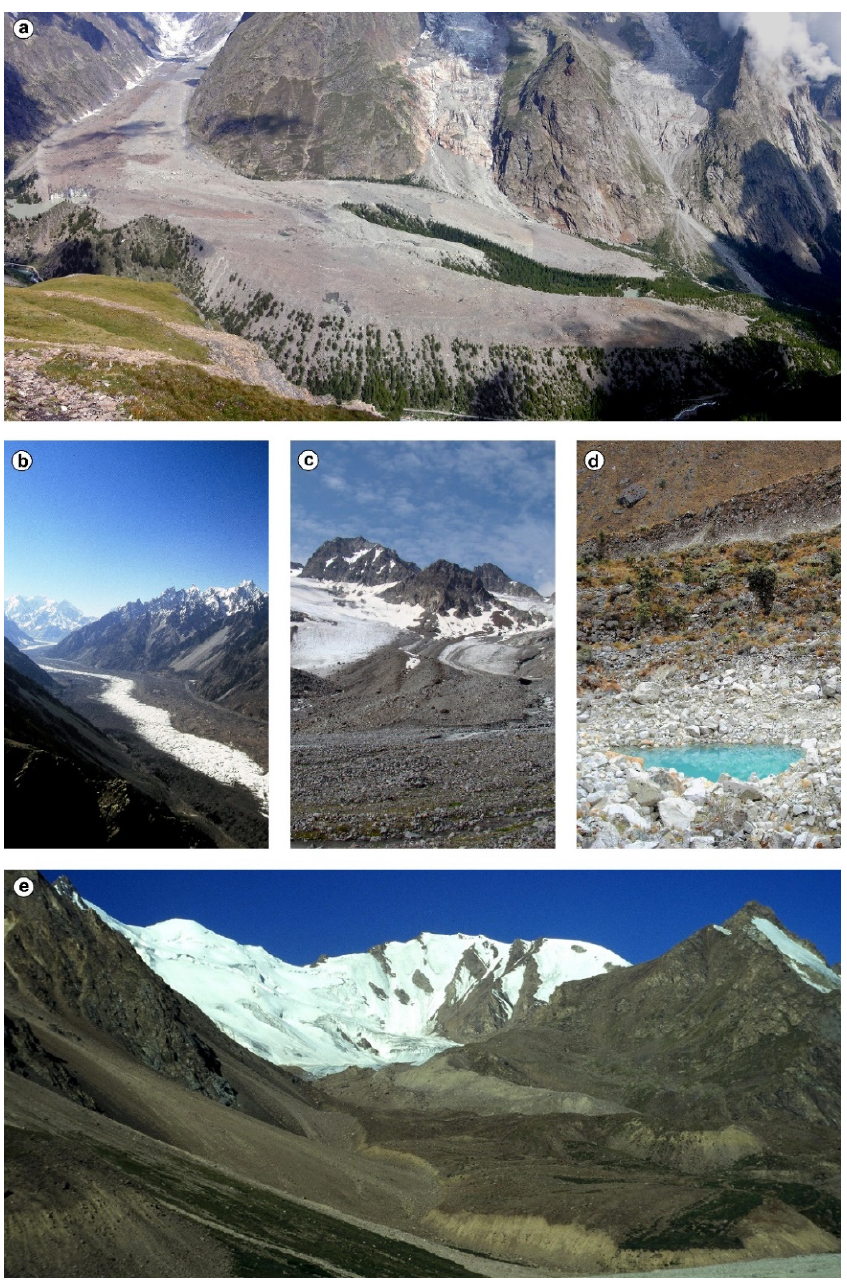
Figure 1. Aspects of DCGs: ( a ) fully covered Miage Glacier (European Alps, Italy); ( b ) debris cover restricted to the lateral margins on Batura Glacier (Karakorum, Pakistan); ( c ) debris cover originating from medial moraines on Jamtalferner (European Alps, Austria); ( d ) supraglacial lake on debris- covered Kinzl Glacier (Peruvian Andes); ( e ) rock glacier of most likely glacial origin in front of a clean-ice glacier (Sailiskji Alatau, Kazakhstan) (photos: ( a , d ) M. Richter; ( b , c , e ) T.